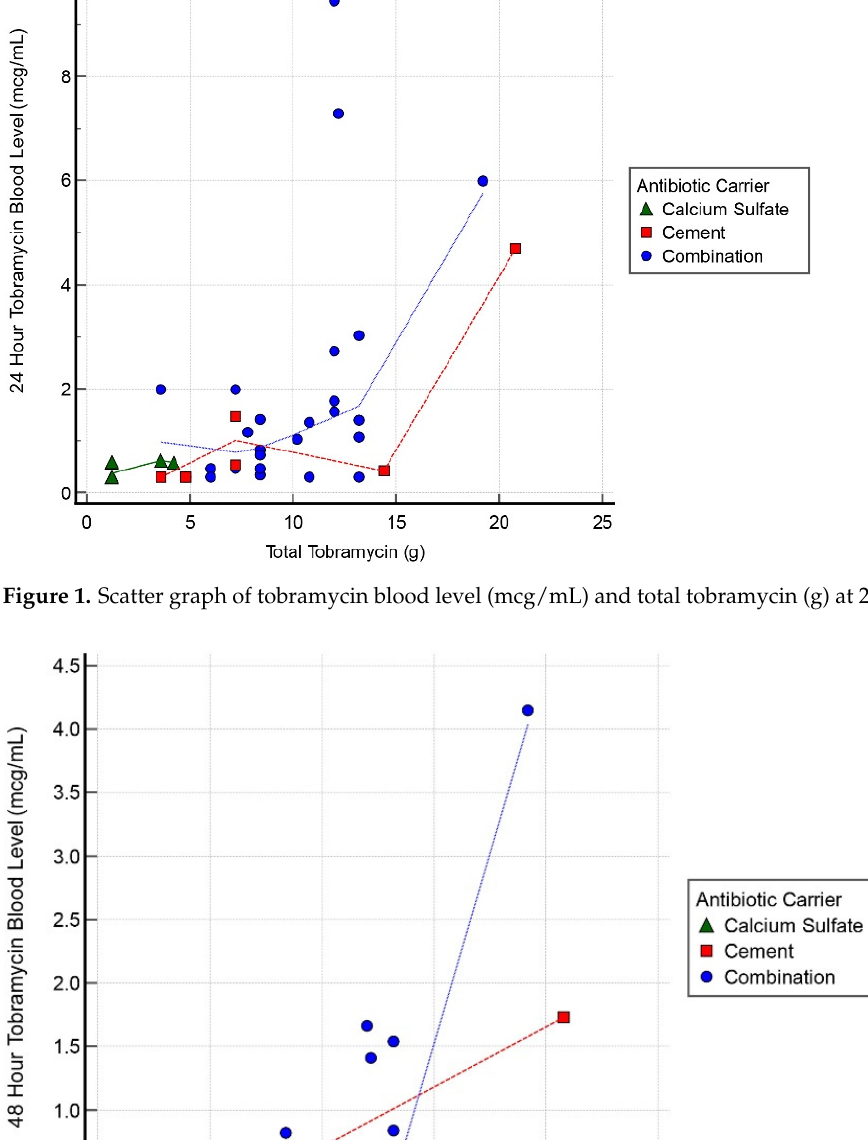
Figure 3. Scatter graph of tobramycin blood level (mcg/mL) and total tobramycin (g) at 72 h inter- val. Tobramycin blood levels were collected at 24, 48, and 72 h postoperatively ( n = 42, n = 35, and n = 55, respectively; Table 3). At 72 h postoperatively, all cases had tobramycin levels measuring inferior to toxicity levels with a mean result of 0.38 ± 0.32 mcg/mL (range,